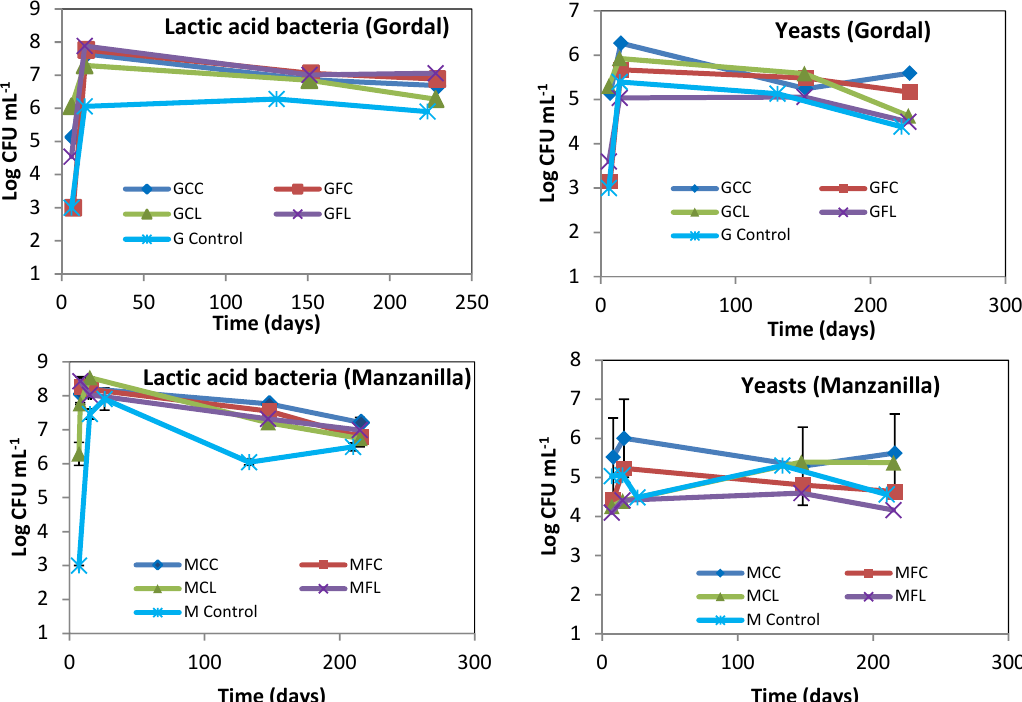
Figure 2. The microbial count of lactic acid bacteria and yeasts during fermentation. The points are the means of duplicate fermenters. Where the error bars (range of data) are not visible, the determinations were within the symbols on the graph. See Table 5 for the meanings of samples abbreviations.